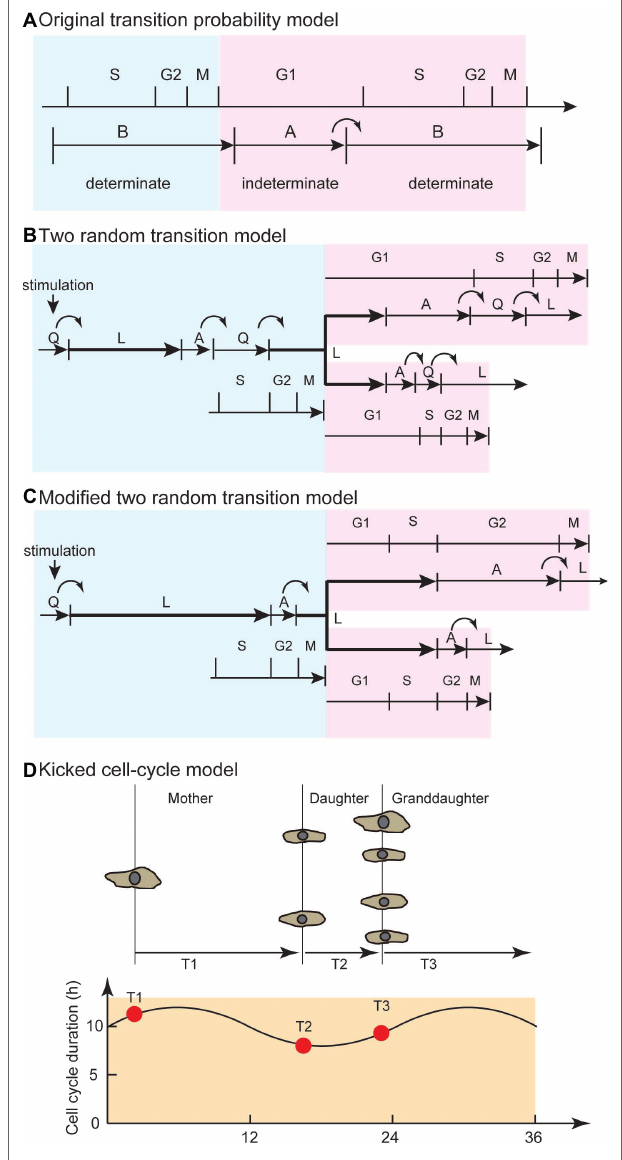
FIGURE 2 | Evolution from the transition probability model to the kicked cell-cycle model to explain temporal correlation in cell pedigree. (A) Original transition probability model. The CDC is separated into A and B states, corresponding to the G1 and S/G2/M phases. The B state has a certain length of time, and transition from A to B occurs in a stochastic manner. This model explains the flat and exponential tail regions in waiting time distribution (alpha curve, Figure 1B ). Blue area corresponds to mother cell, whereas red area corresponds to daughter cell. (B) Two random transition probability models. This model explains the exponential tail regions (alpha curve) in waiting time distribution and temporal correlation between mother and daughter cells due to QL and AQ stochastic transitions and overlapping L phase between mother and sister cells. Stochastic QL transition occurs at transition from serum-deprived quiescent state. Stochastic AQ transition occurs at the G1/S transition. Q-L-A sequence is maintained in quiescent and proliferating cells. (C) Modified two random transition models, with modifications to explain new experimental findings (van Wijk et al., 1977). Stochastic QL and AL transitions occur at G1 and G2 phase, respectively, to explain variability among unrelated cells and between sister pairs.